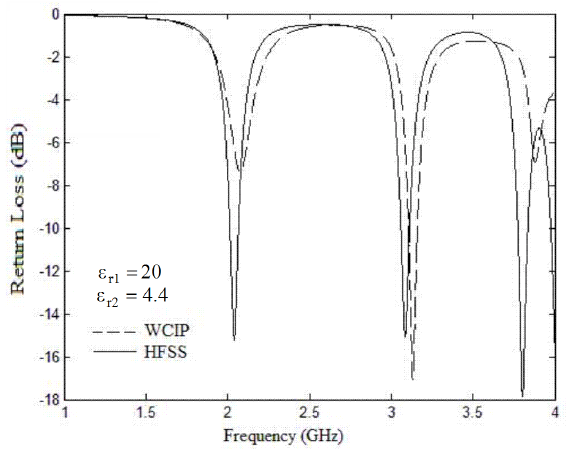
Figure 3: Return loss versus frequency for rectangular patch